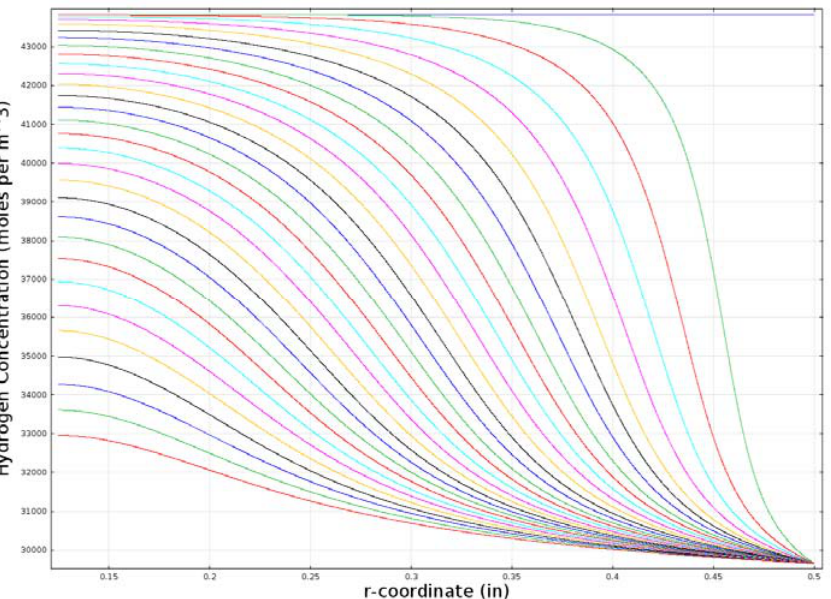
Figure 11. Modeled hydrogen concentration profile in a one inch-diameter cylindrical bed (k = 0.2 W/mK).